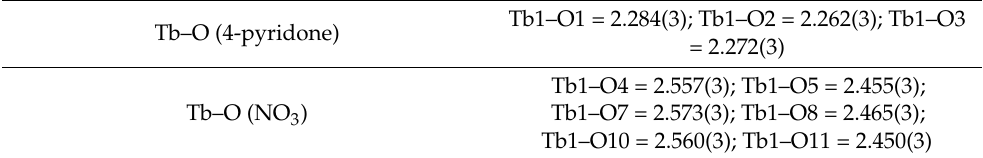
Table 2. Selected bond lengths for compound 5c · 2CH 3 CN .